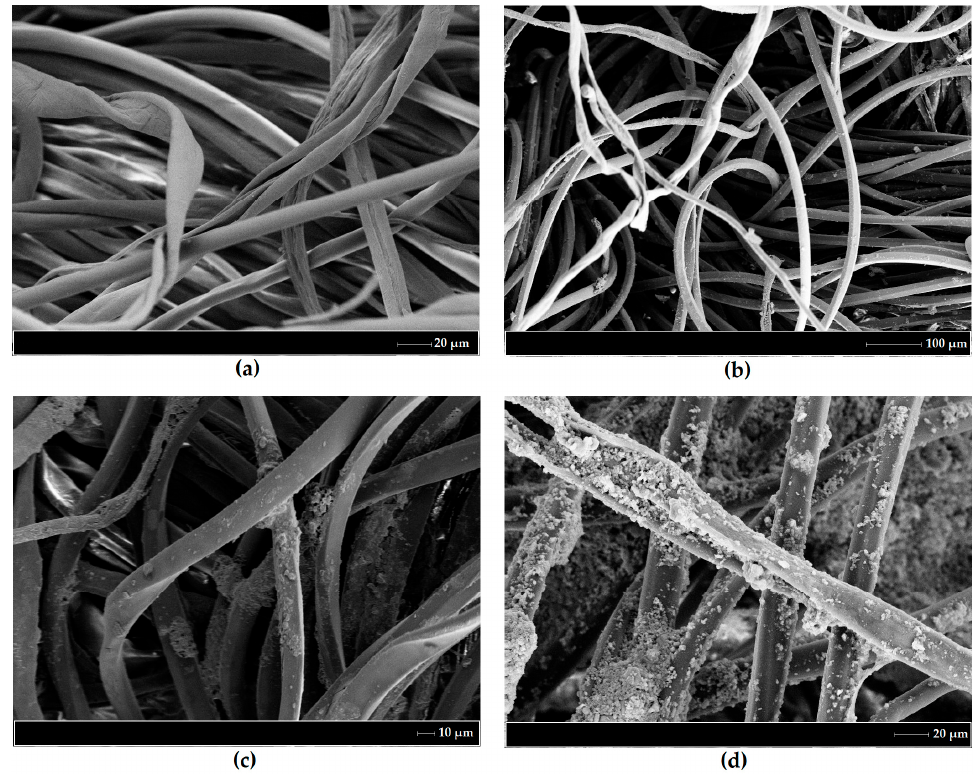
Figure 8. The SEM results of the cotton/elastane samples: ( a ) untreated; ( b ) 10 wt % CaCl 2 ; ( c ) 25 wt % CaCl 2 ; ( d ): 50 wt % CaCl 2 .